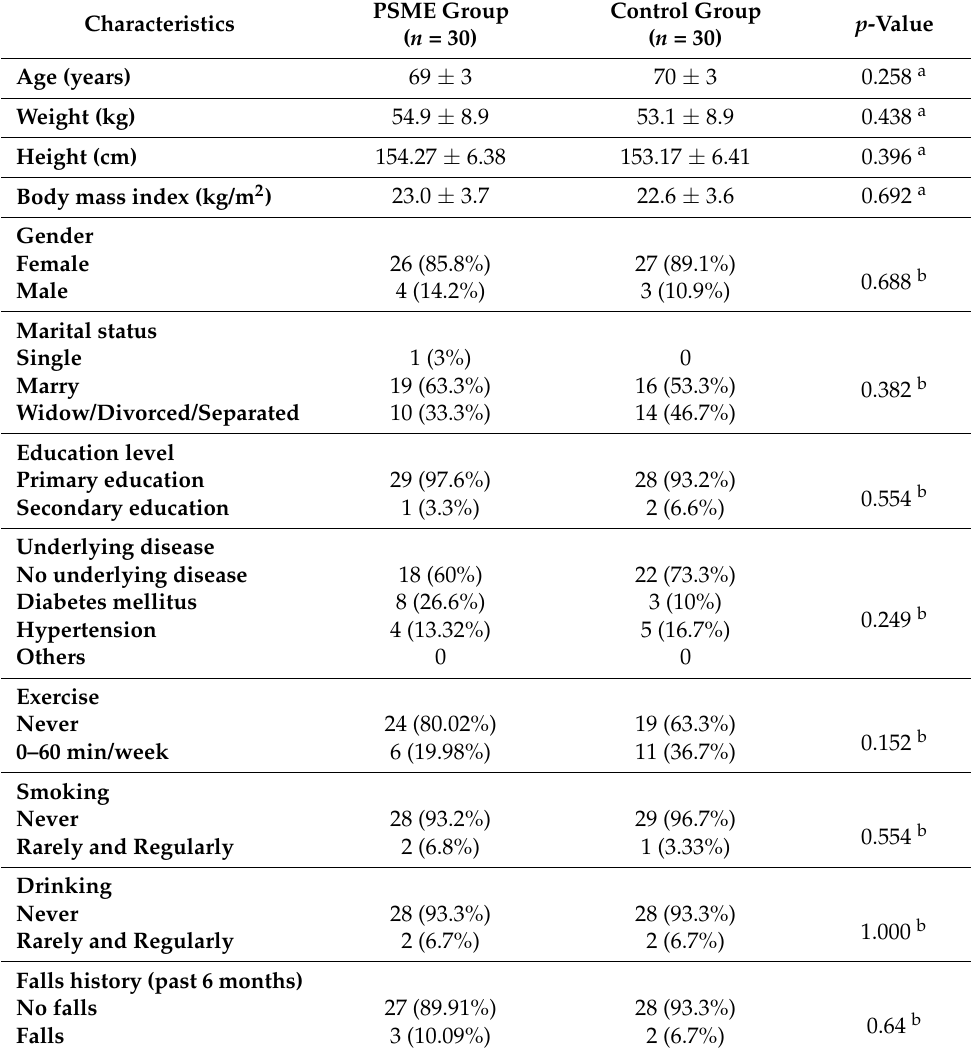
Table 2. Participant’s demographic data and health